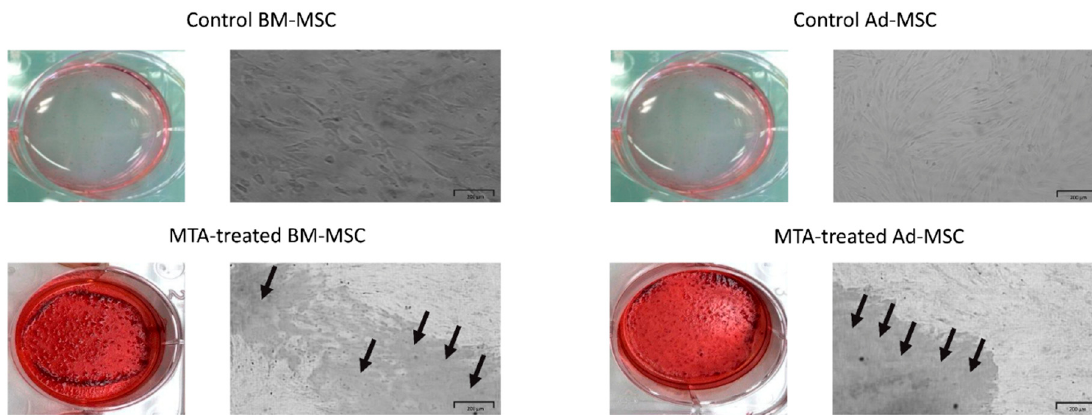
Figure 4. Alizarin red S staining of Ad/BM-MSCs after 14 days of treatment with 0.2 mg/mL MTA- conditioned media. No mineralized nodule formation can be seen in control groups. The arrows indicate the mineral deposits prior to dye extraction for semiquantification. Scale bar represents 200 µ m.